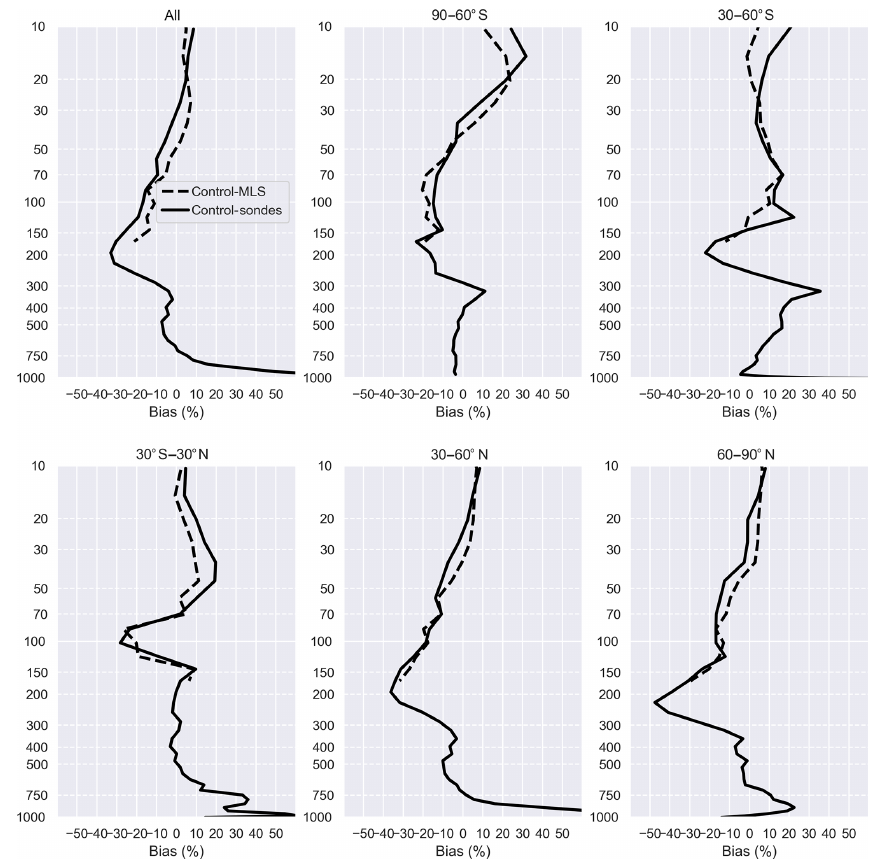
Figure 4. Relative bias of the control simulation with respect to radiosoundings (solid lines) and MLS (dotted lines). Same plots as in Fig 3.